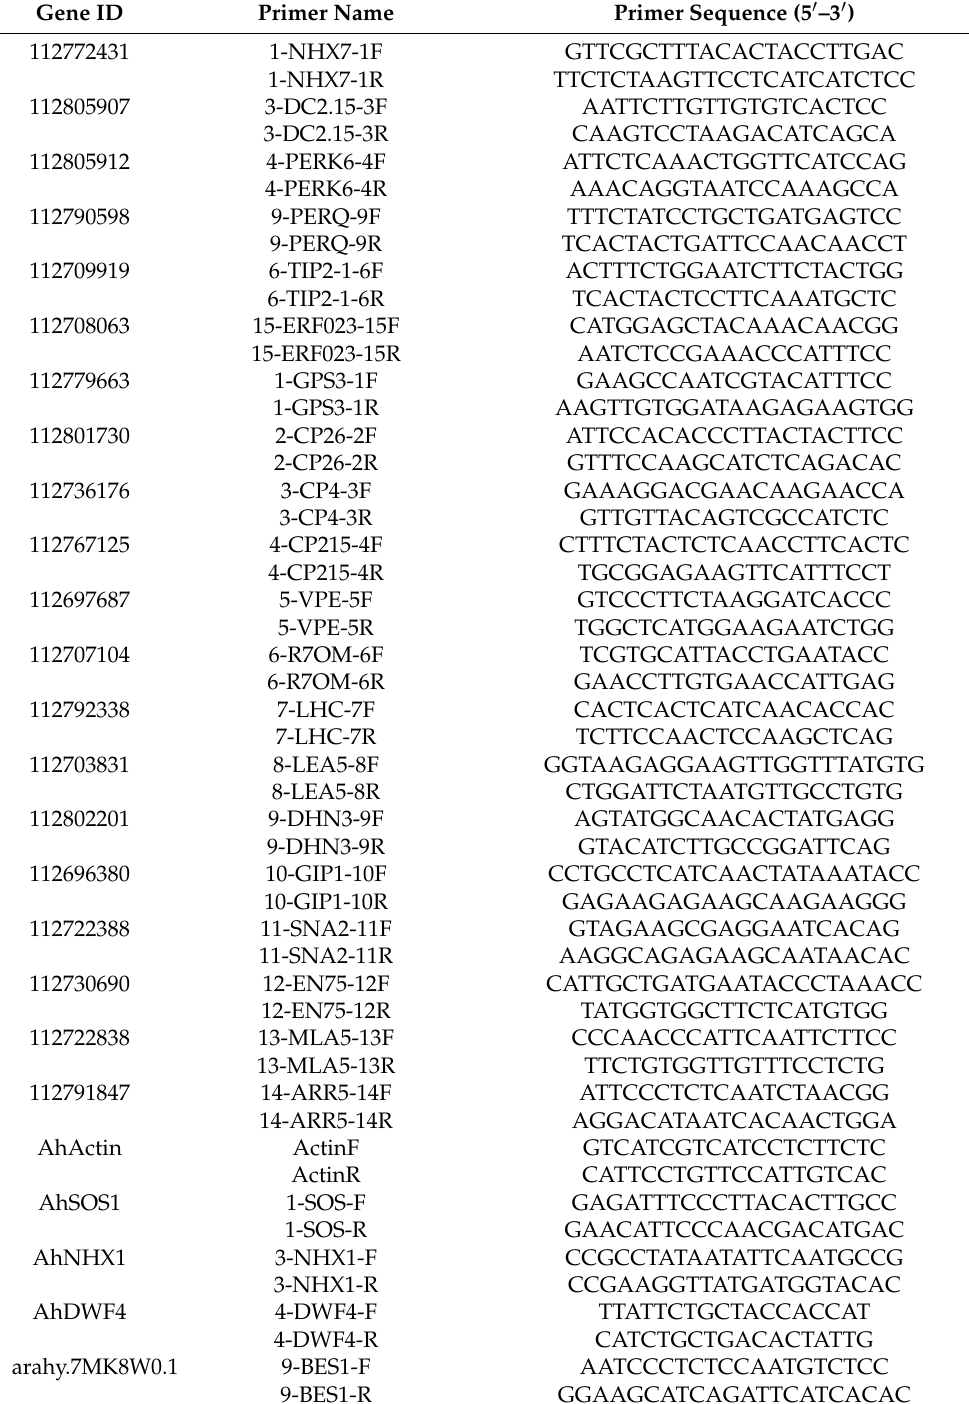
Table 3. The following primers were used in this experiment. Gene